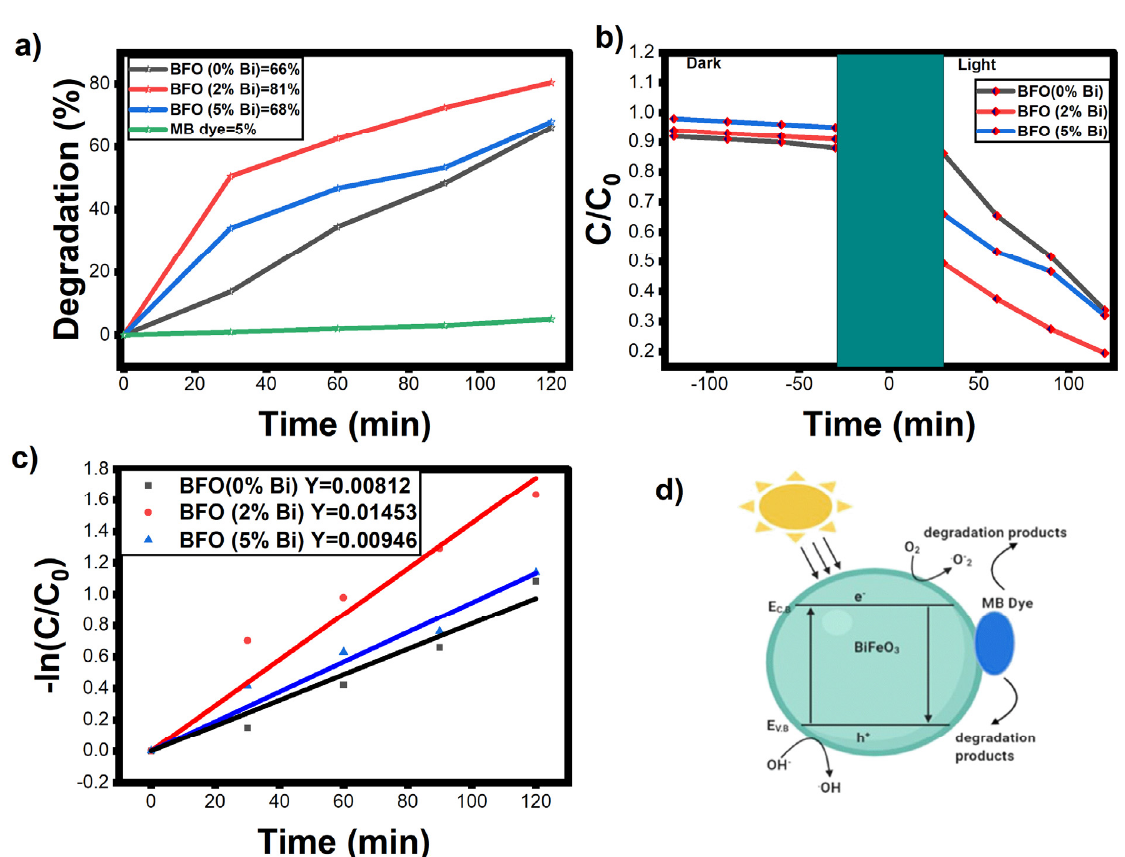
Figure 8. Photocatalytic dye degradation ( a ) efficiency, ( b ) C / C 0, ( c ) kinetics and ( d ) mechanism of the BFO nanoparticles.